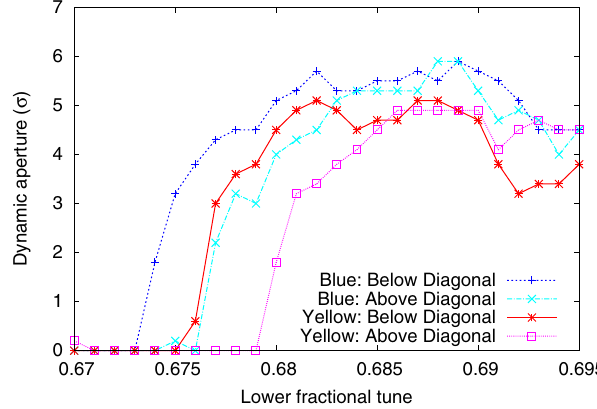
FIG. 20. Calculated dynamic apertures with beam-beam inter- actions versus the β (cid:1) s at the collisional IP6 and IP8. The particle energy is 100 GeV.